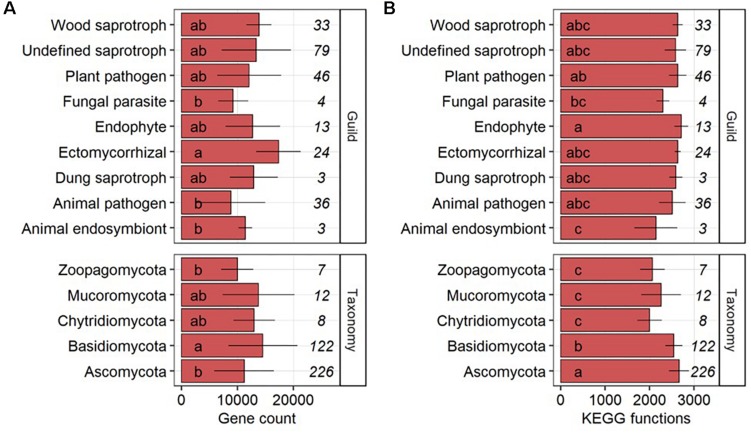
Gene counts (A) and the number of different KEGG functions (B) per genome across fungal guilds and phyla shown as average with standard deviation. The number of fungal genomes per guild and phylum is given in italic. Groups followed by the same letter are not significantly different according to the HSD-test (P-value > 0.05).